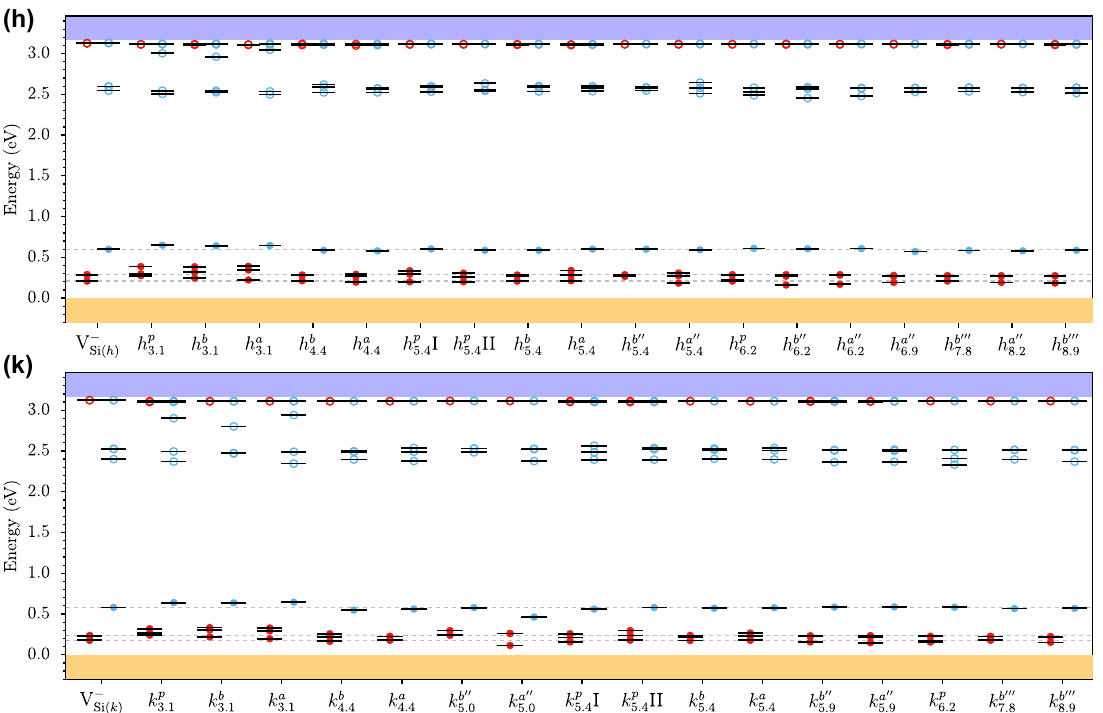
Figure 4: The Kohn–Sham eigenvalues (HSE results) for the modified vacancy for the (h) and (k) configurations compared with the isolated silicon defects. On the x -axis are the different configurations, where the subscript is the distance between the carbon antisite and the silicon vacancy. The dashed lines denote the eigenvalues for the occupied defect states of isolated silicon vacancy for both h and k configurations. The red and blue filled dots represent occupied states in each spin channel. Unfilled dots represent unoccupied states.